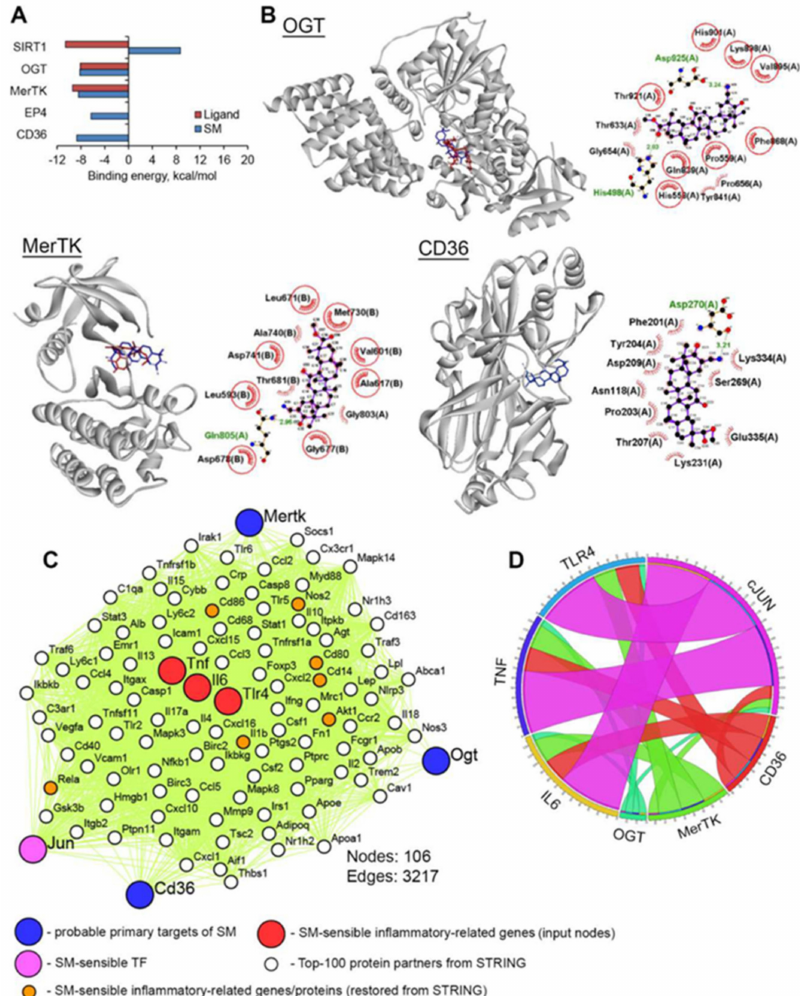
Figure 10. OGT, MerTK, and CD36 are probable primary targets of SM. ( A ) Binding energies of SM and proteins for which the modulation of activity / expression is associated with the LPS-induced inflammatory response in macrophages, according to data mining analysis. The binding energies were calculated using Autodock Vina. ( B ) The modes of binding of SM to OGT, MerTK, and CD36. Stereo presentation of the docked poses of SM in the listed proteins superimposed on the corresponding inhibitor-bound structures (OGT, MerTK) or phosphatidylserine recognition region (CD36) was created using BIOVIA Discovery Studio. Structures of SM and inhibitors are depicted as blue and red sticks, respectively. The 2D representations of docked poses of SM in mentioned proteins were reconstructed by LigPlot + . The green dashed lines and combs represent hydrogen bonds and non-direct interactions, respectively. Common amino acids, interacting with both SM and inhibitors, are highlighted in red circles. ( C ) The probable primary targets of SM and their association with SM-susceptible genes. The protein–protein interaction network was reconstructed using the STRING database (confidence score > 0.7, number of interactors = 100) and visualized by Cytoscape. ( D) The number of the shortest paths between revealed probable protein targets of SM and pro-inflammatory genes in the protein–protein interaction (PPI) network. Only paths with length ≤ 1 node were calculated using the Pesca